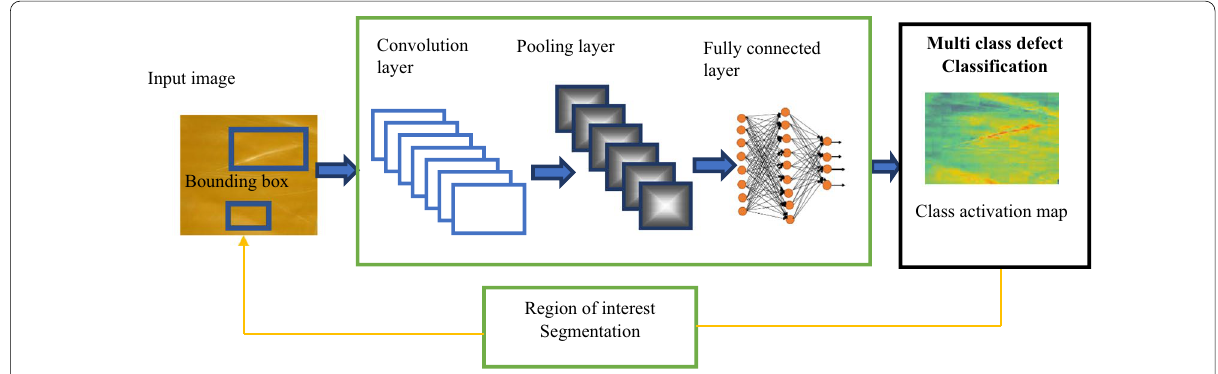
Fig. 4 Block diagram of deep learning methodology for multi defect classification and